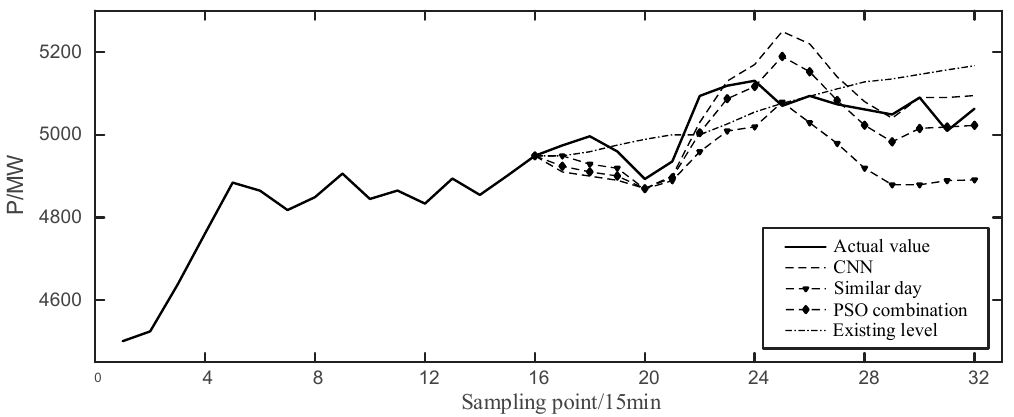
Figure 7. Predicted results of multiple models at 0:00–4:00 on 6 November 2019.